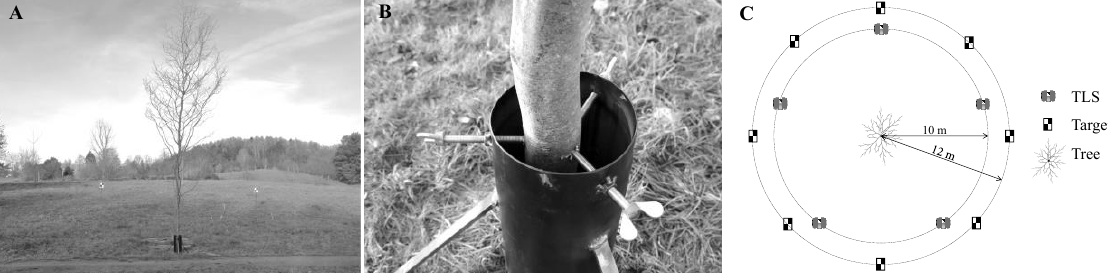
Figure 3. A subset of 17 sample trees was carefully felled and re-erected ( A ) in an open space in ( B ) a tailor-made tree holder. These sample trees were then scanned (by TLS) using the scan and target locations as illustrated in ( C ).